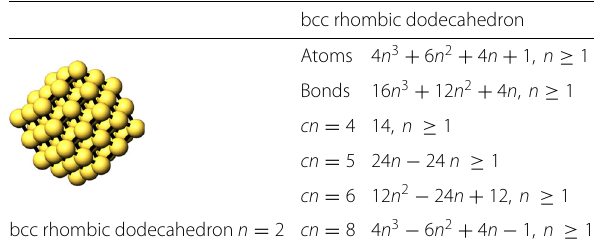
Table 5 Magic formulas for the bcc rhombic dodecahedron